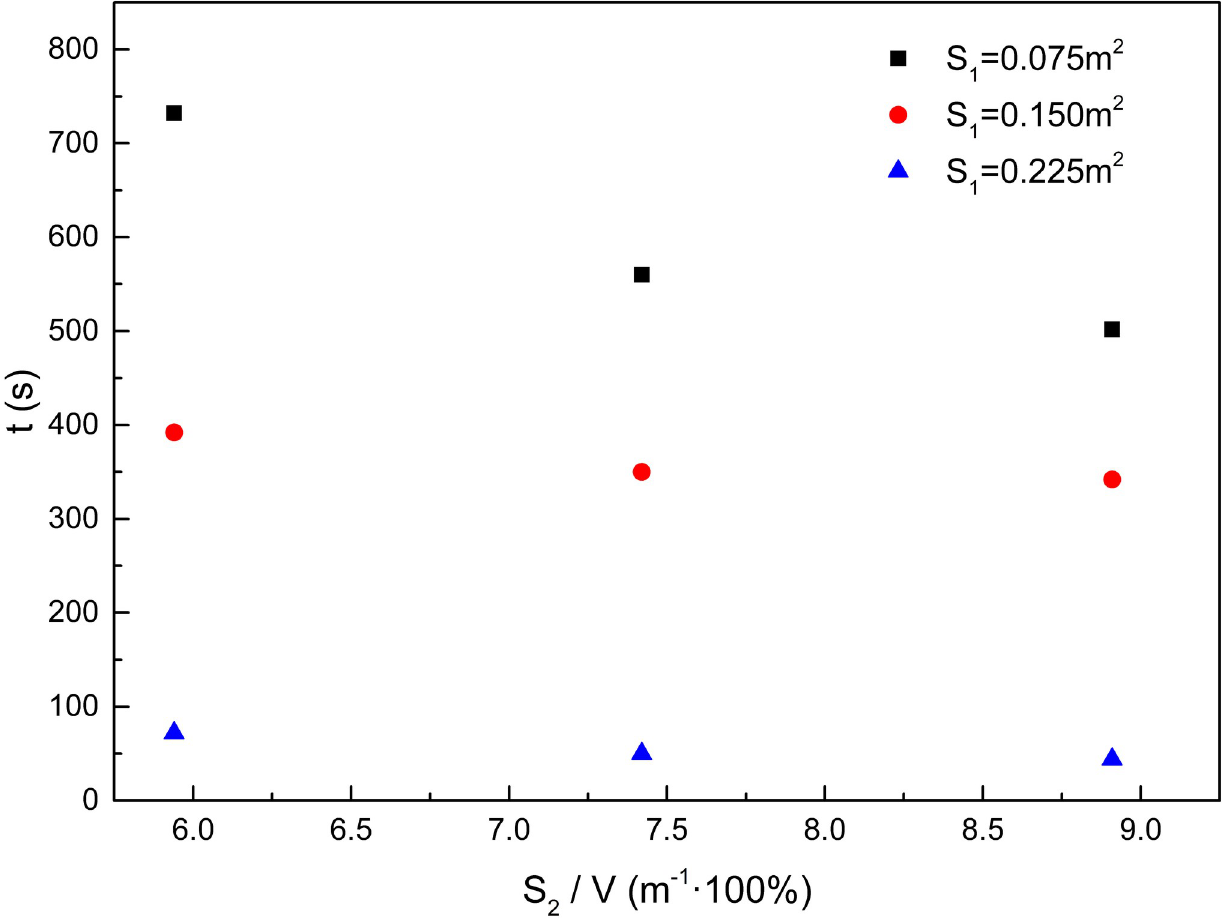
Fig 8. Effect of the upper surface area of woodblocks on backdraft